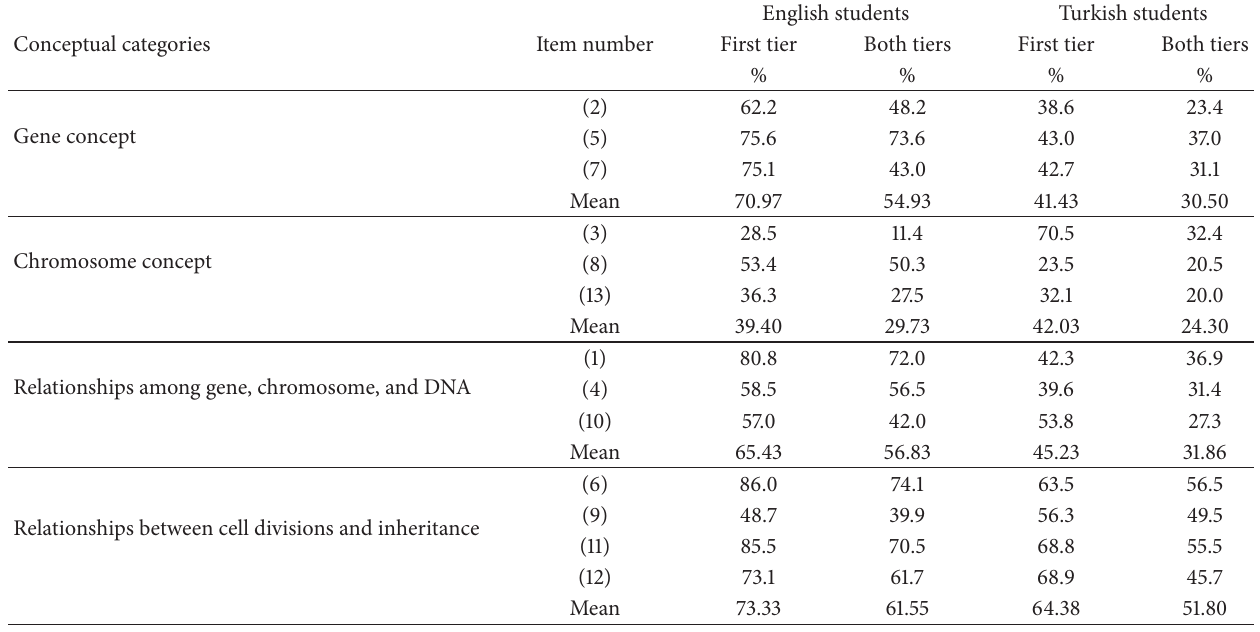
Table 1: The percentage of students’ correct answers to the first tier and to both tiers of items in TGCT relating to the conceptual